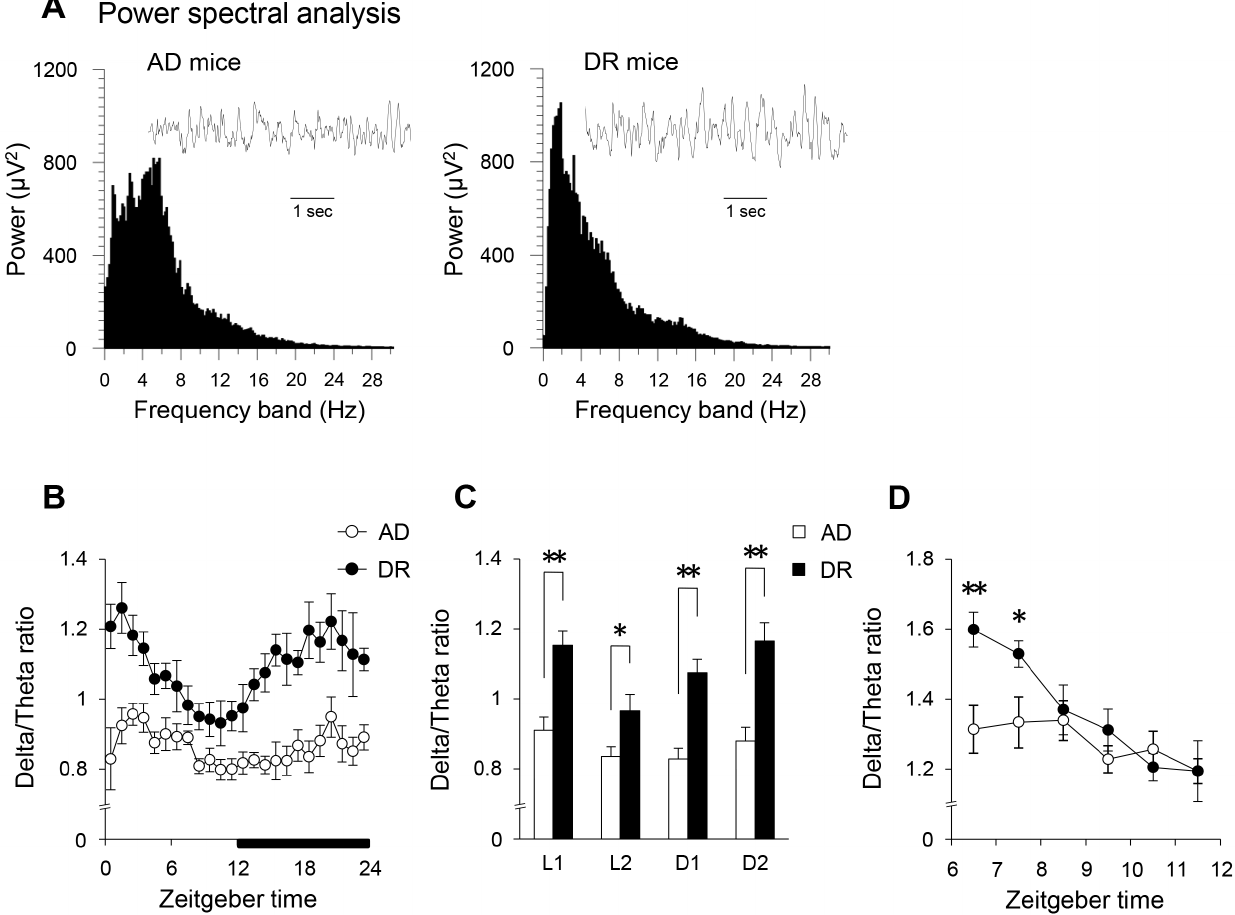
Figure 3. The influence of dietary restriction during gestation on sleep homeostasis in adult offspring mice. Power spectral analysis of EEG during NREM sleep (A). Hourly time course changes of EEG delta/theta ratio in NREM sleep (B), and the averages for each 6-hour period (C) across ZT0-6 (L1), ZT6-12 (L2), ZT12-18 (D1), and ZT18-24 (D2). Six-hour changes of the rebound rate of delta/theta ratios after sleep deprivation (D). Open bars and circles indicate AD mice. Closed bars and circles indicate DR mice. Data represent means 6 SEM (A–D; n=6). **p , 0.01 and *p , 0.05 indicate a significant difference.